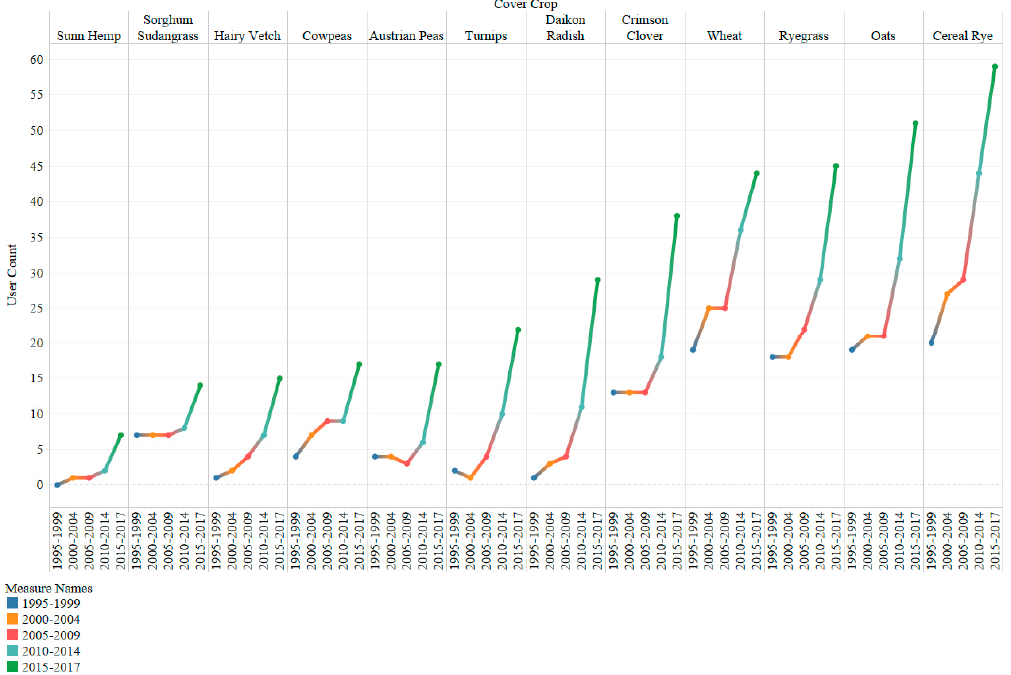
Figure 4. User Count for each specific cover crop based on year range.